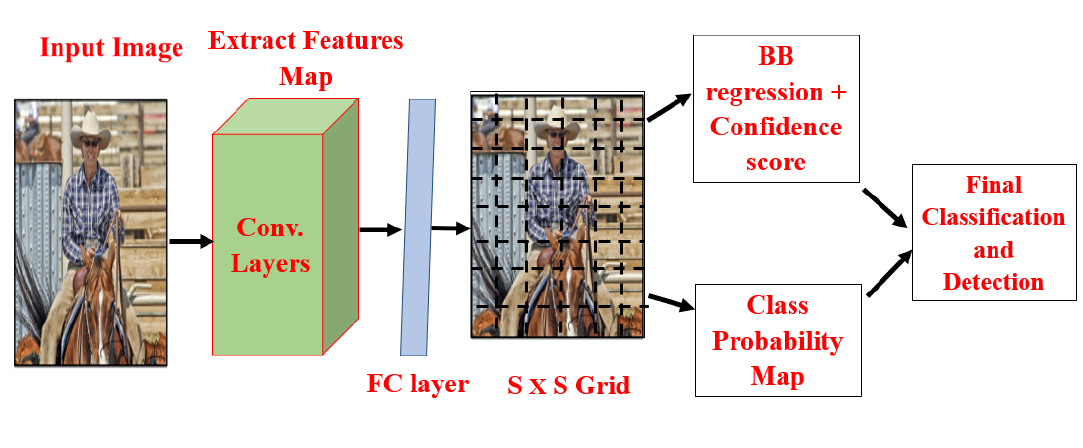
Figure 10. You only look once architecture [40].